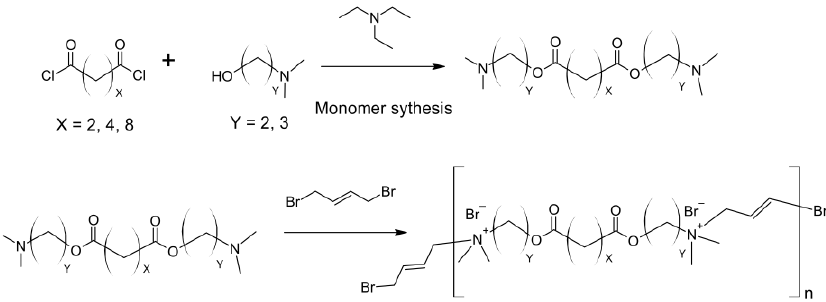
Figure 20. Scheme of the polyionenes esters synthesis based on [340].